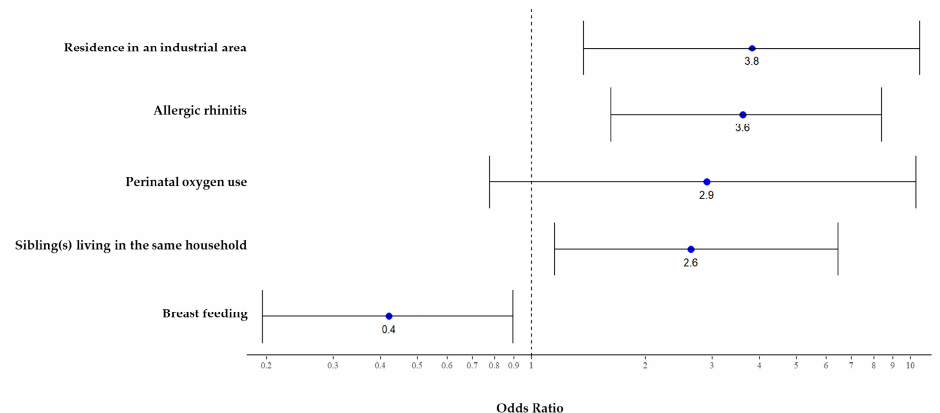
Figure 1. Odds ratios and 95% confidence intervals of the association between potential risk and protective factors and asthma outcomes at the age of six years.